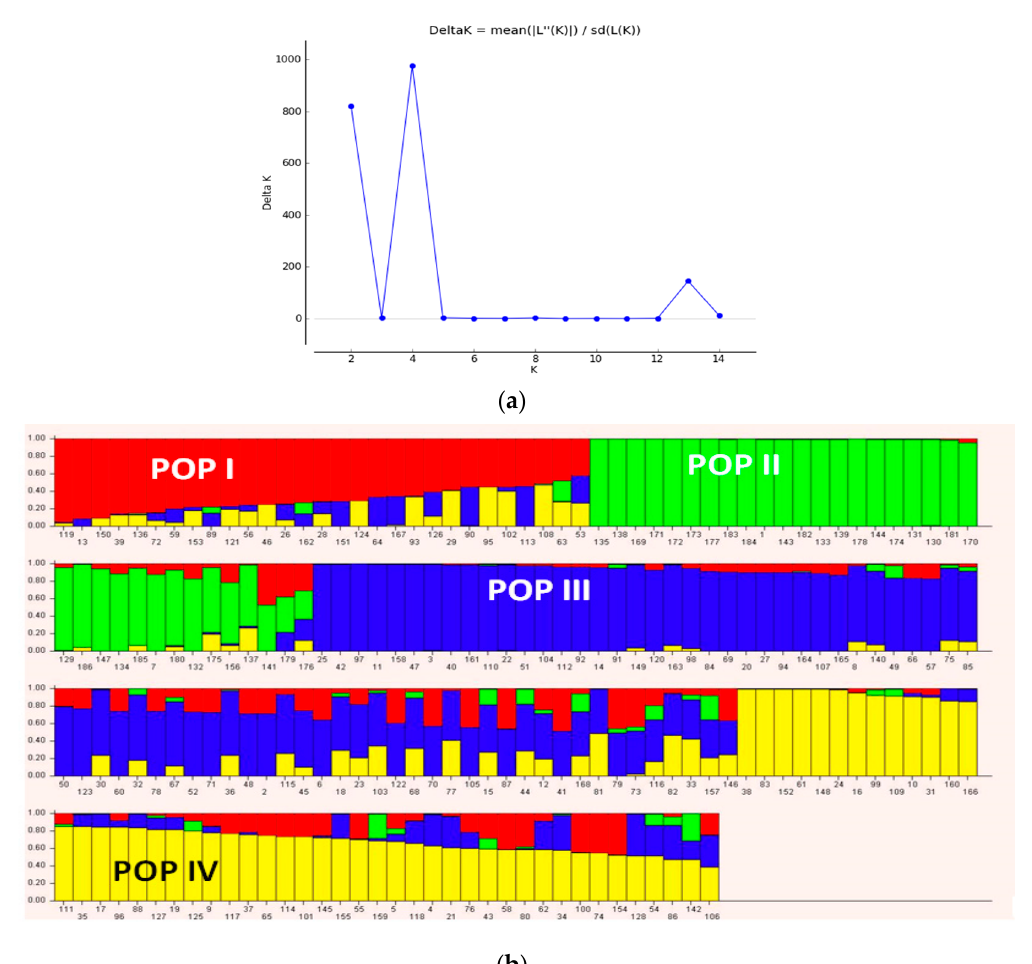
Figure 5. Determination of the optimal value of K = 4 and population structure of 186 chickpea genotypes using DArTseq-SNP markers.